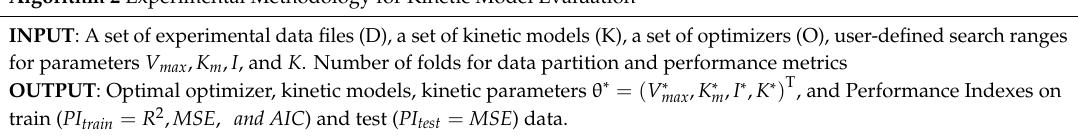
Algorithm 2 Experimental Methodology for Kinetic Model